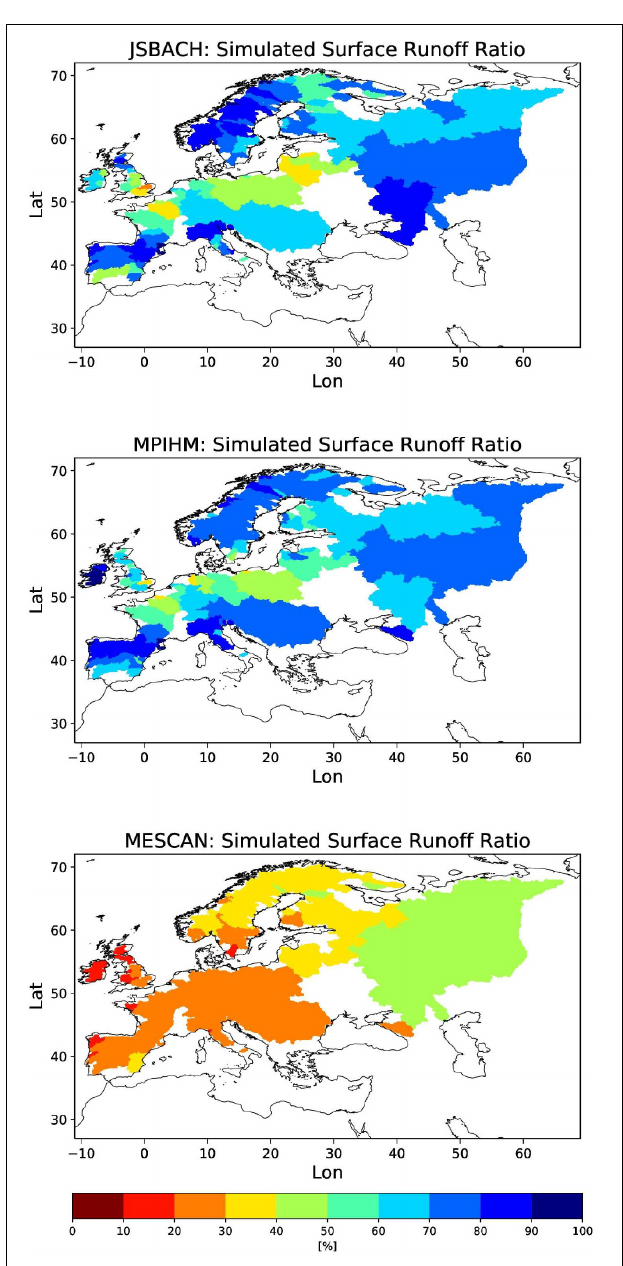
FIGURE 12 | Simulated surface runoff ratio (catchment averaged surface runoff divided by total runoff) for JSBACH (upper panel) , MPIHM (middle panel) and MESCAN (lower panel)